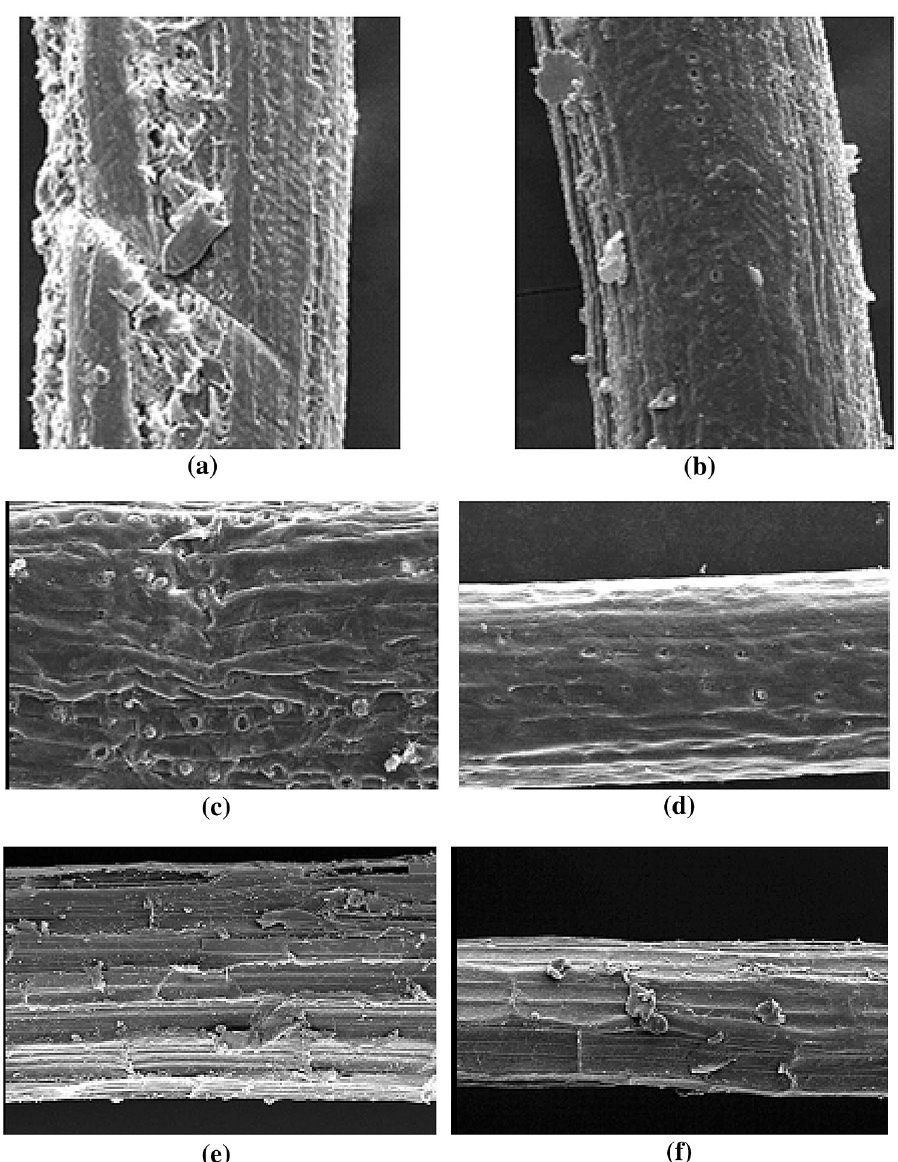
Fig. 7 SEM images of a untreated Sterculia Foetida, b Alkali Treated Sterculia Foetida, c untreated Delonix Regia, d alkali treated Delonix Regia, e untreated Caryotta Obtusa and